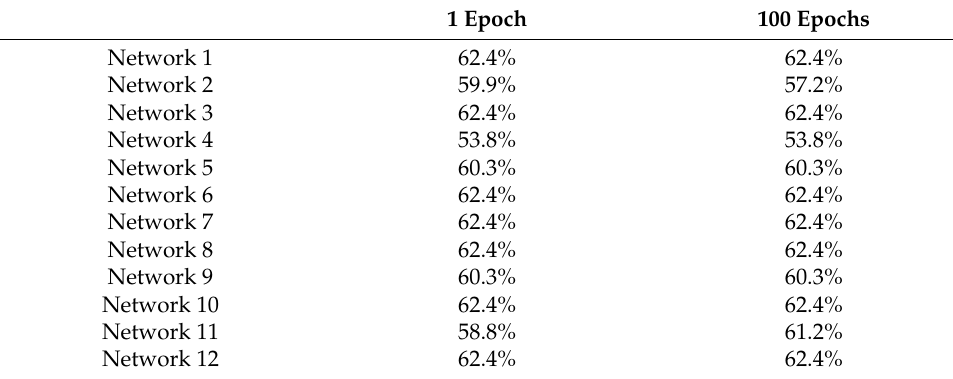
Table 3. Network accuracy results for 1 and 100 training epochs.